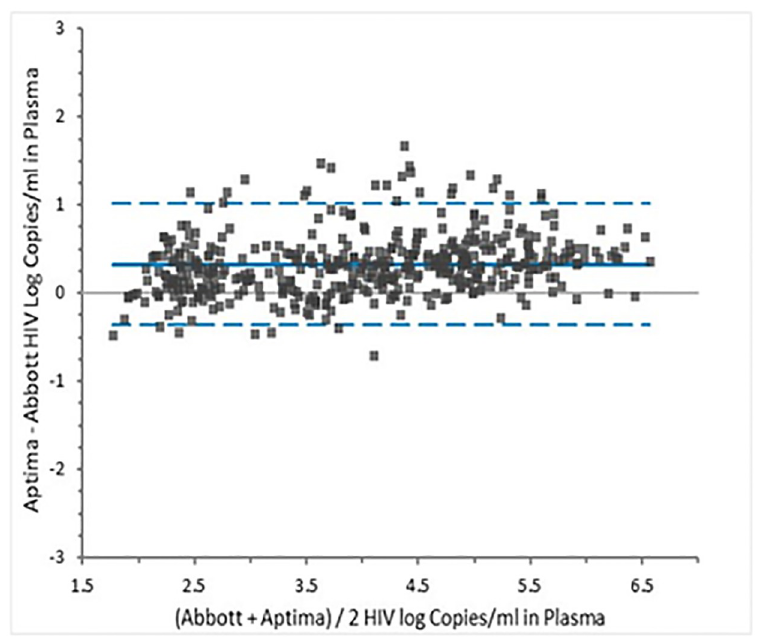
Fig 2. Bland Altman analysis of HIV VL results for 436 plasma samples tested in Aptima and Abbott RT assays. Comparison of fresh DBS tested on Aptima DBS and Abbott RT assays